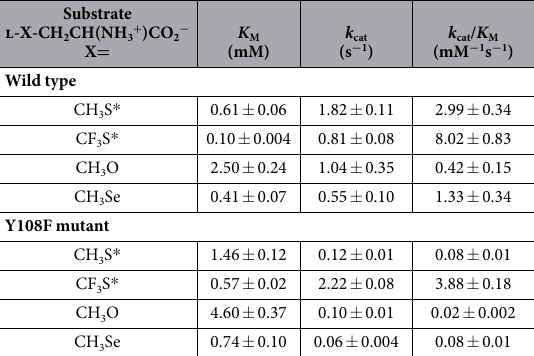
Table 1. Kinetic parameters toward methionine and methionine analogues. Values are means ± S.D. (n = 5 or 6). * These values are referred from our previous study 10 .